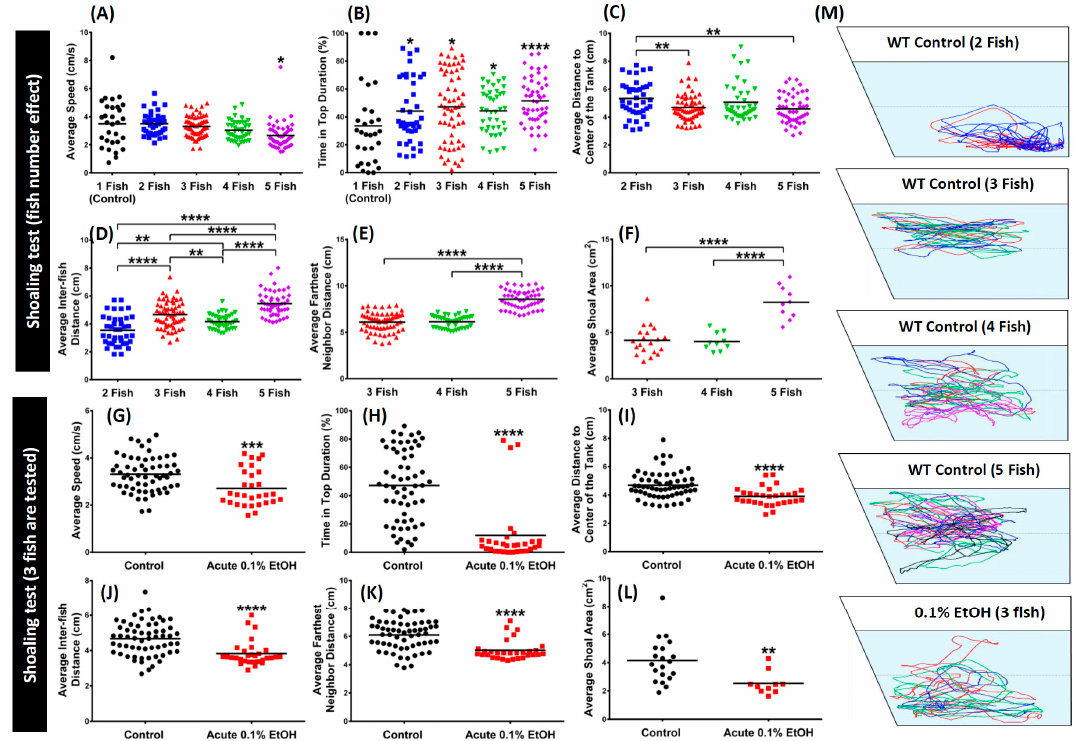
Figure 4. Comparison of zebrafish shoaling behavior affected by different shoal sizes or 0.1% ethanol exposure. For shoal size comparison, six endpoints of ( A ) average speed, ( B ) time in top duration, ( C ) average distance to center of the tank, ( D ) average inter-fish distance, ( E ) average farthest neighbor distance, ( F ) average shoal area were analyzed. The data are expressed as the means and were analyzed by Mann-Whitney test ( n 1 Fish = 30; n 2 Fish = 40; n 3 Fish = 60; n 3 Fish = 40; n 5 Fish = 50; * p < 0.05, ** p < 0.01****, p < 0.0001). For 0.1% ethanol exposure (shoaling size = 3), six endpoints of ( G ) average speed, ( H ) time in top duration, ( I ) average distance to center of the tank, ( J ) average inter-fish distance, ( K ) average farthest neighbor distance, ( L ) average shoal area were analyzed. The data are expressed as the means and were analyzed by Mann-Whitney test ( n = 30; ** p < 0.01, *** p < 0.001, **** p < 0.0001). The locomotion trajectories for shoaling were summarized in ( M ).